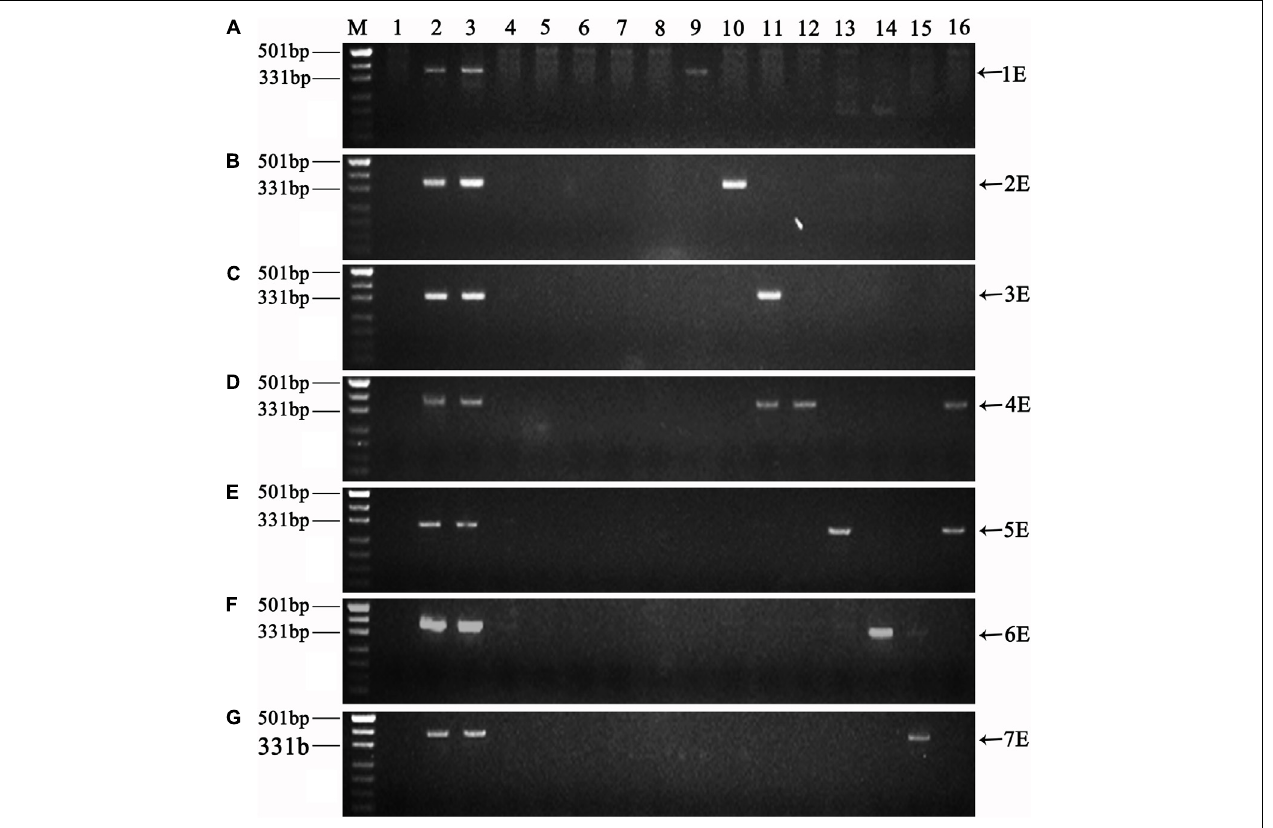
FIGURE 6 | Amplification patterns of E-genome specific molecular markers. (A-G) Specific molecular markers of chromosomes 1E to 7E. Lanes: M Marker (DL500); 1 CS; 2 Tetraploid Th. elongatum PI531750; 3 8801; 4 SM482; 5 SM921; 6 SM51; 7 CM104; 8 CN16; 9 K16-712-1-2; 10 K16-681-4; 11 K16-562-3; 12 K17-1089-1; 13 K17-1084-3; 14 K17-1065-5; 15 K16-2521-1-2; 16 K15-1033-8-2. Arrows show the diagnostic amplification products of tetraploid Th. elongatum 1E-7E